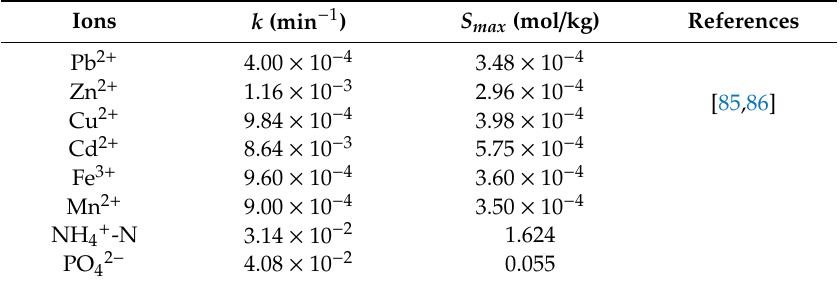
Table 9. Parameters of chemical pollutants for adsorption.